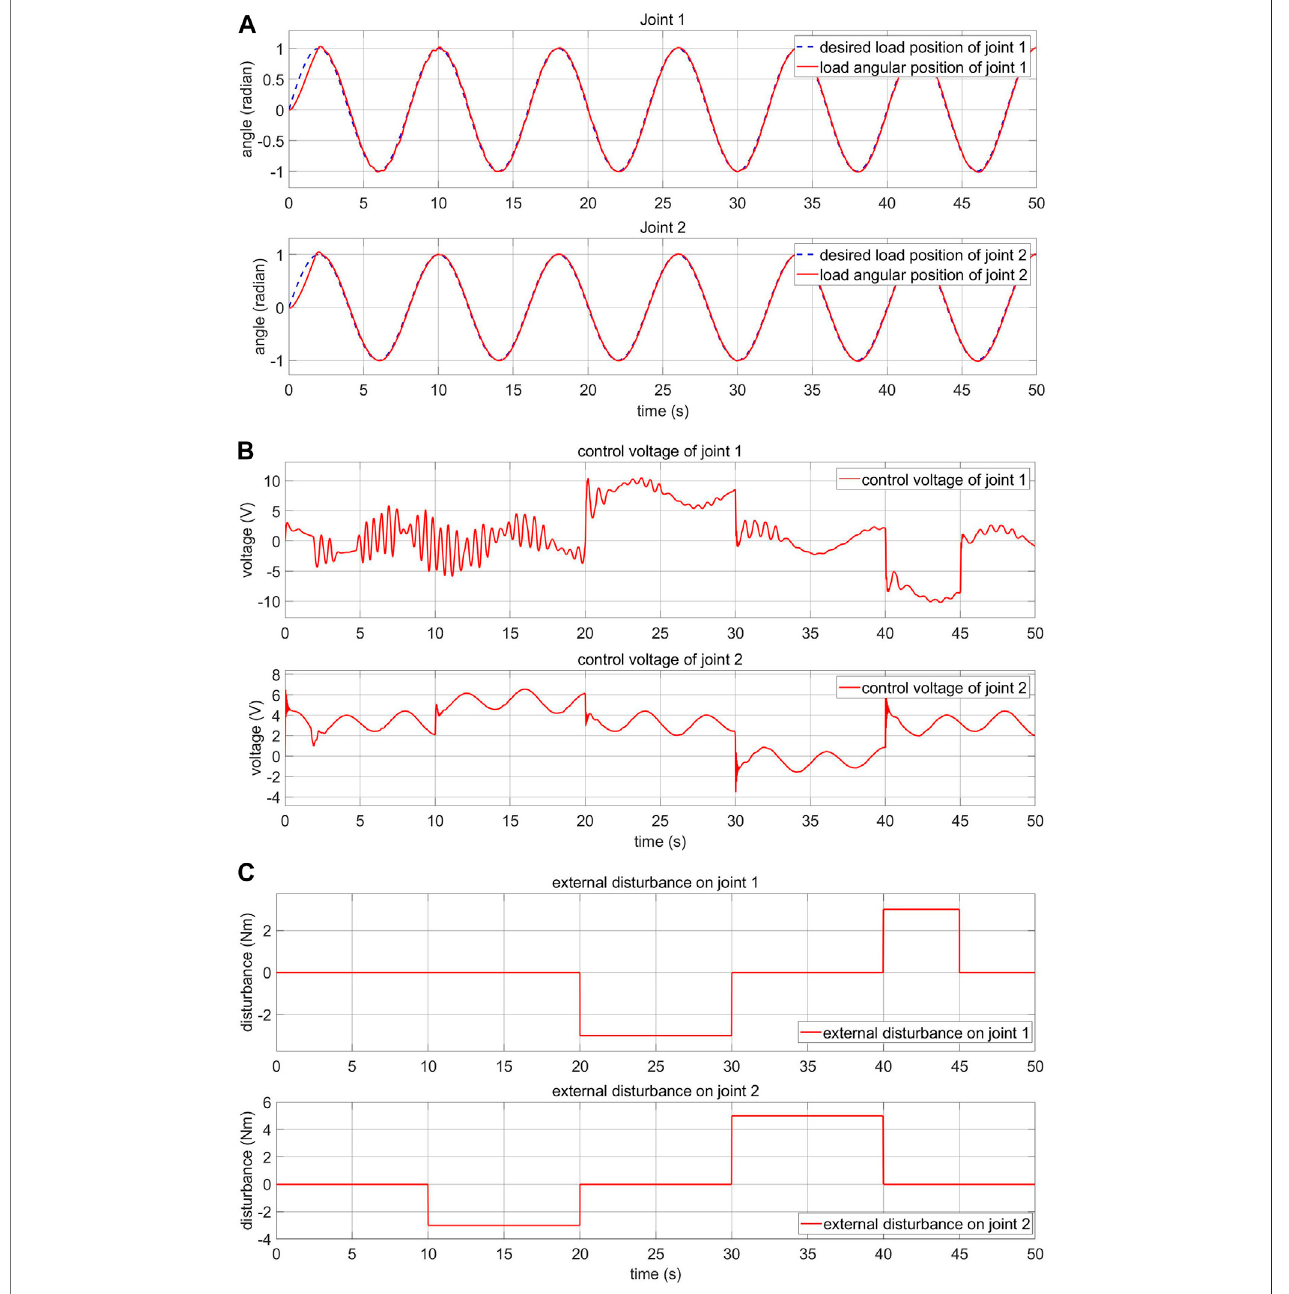
FIGURE 14 | Load-side response and control voltage of the FPIC-MRAC with human-machine interaction (A) load-side response (B) control voltage (C) external disturbance.